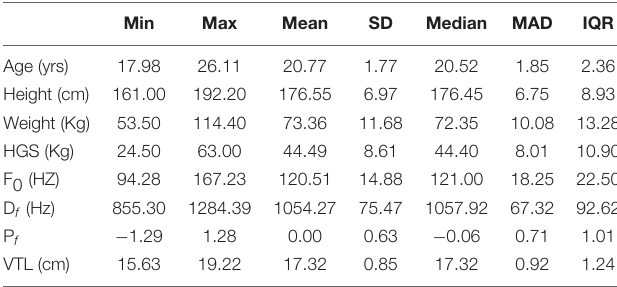
TABLE 2 | Descriptive statistics for the male sample.